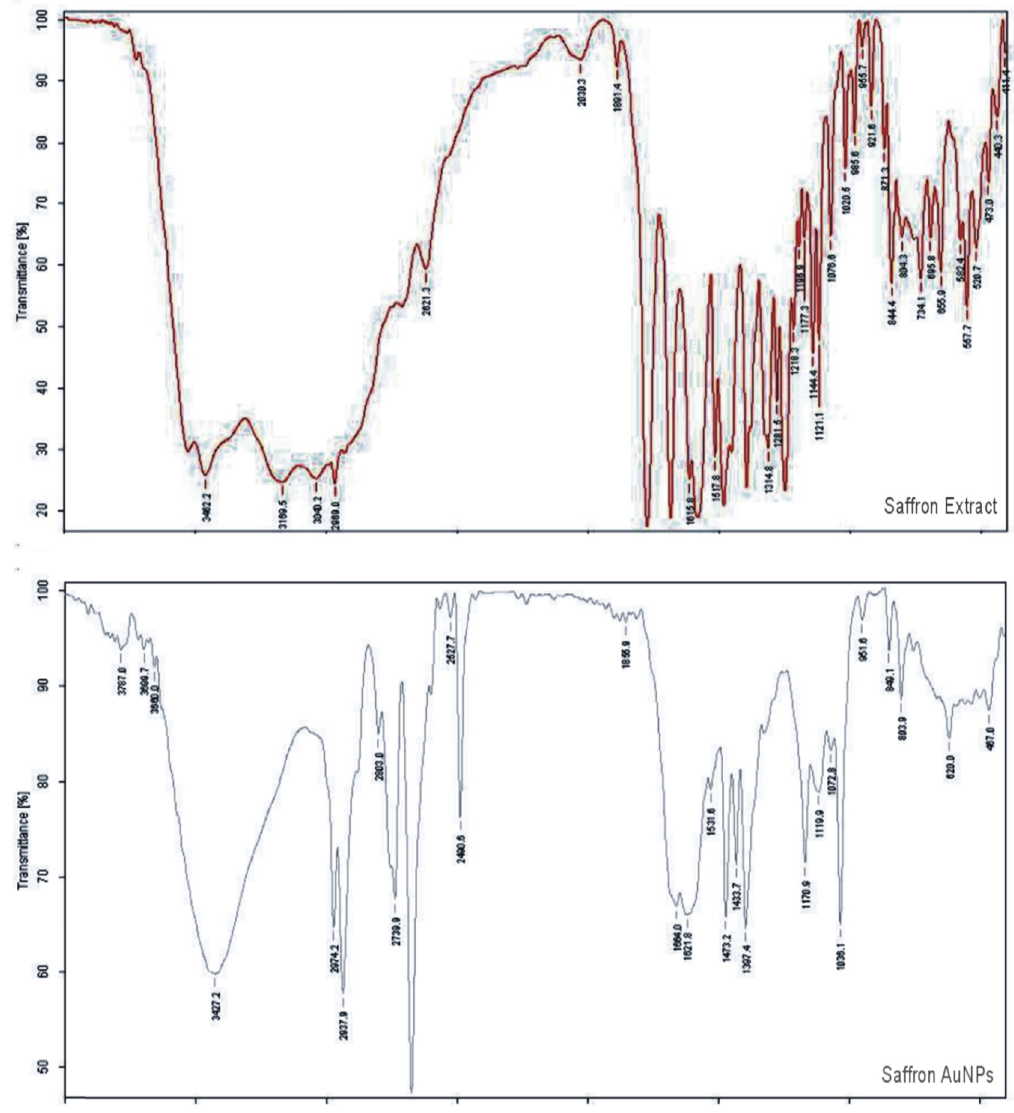
Figure 12: FTIR spectra of sa ff ron extract ( upper ) and its SS - AuNPs ( lower )